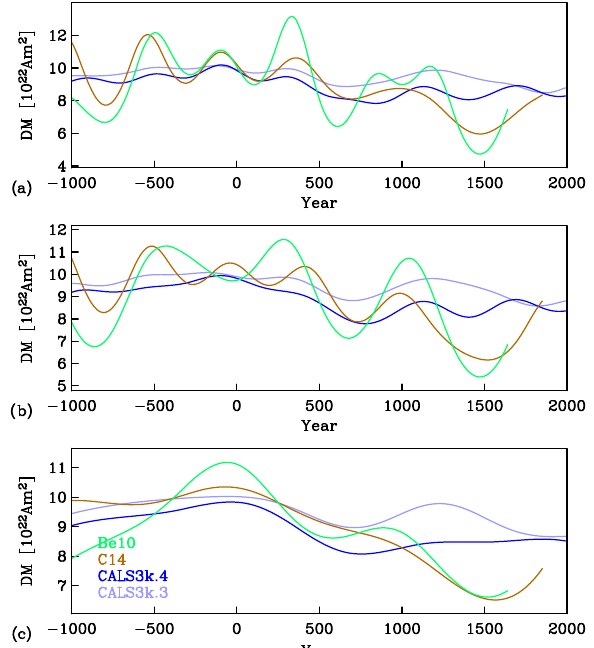
Fig. 6. Dipole moment reconstructions from geomagnetic models CALS3k.3 (light blue) and CALS3k.4 (dark blue) and based on 14 C (brown) and 10 Be (green) records. The radionuclide-based recon- structions are normalised that they exhibit the same average intensity as suggested by the CALS3k.4 model. All reconstructions are low- pass filtered with cut-off frequency 1/400 yrs (a), 1/500 yrs (b) and 1/1000 yrs